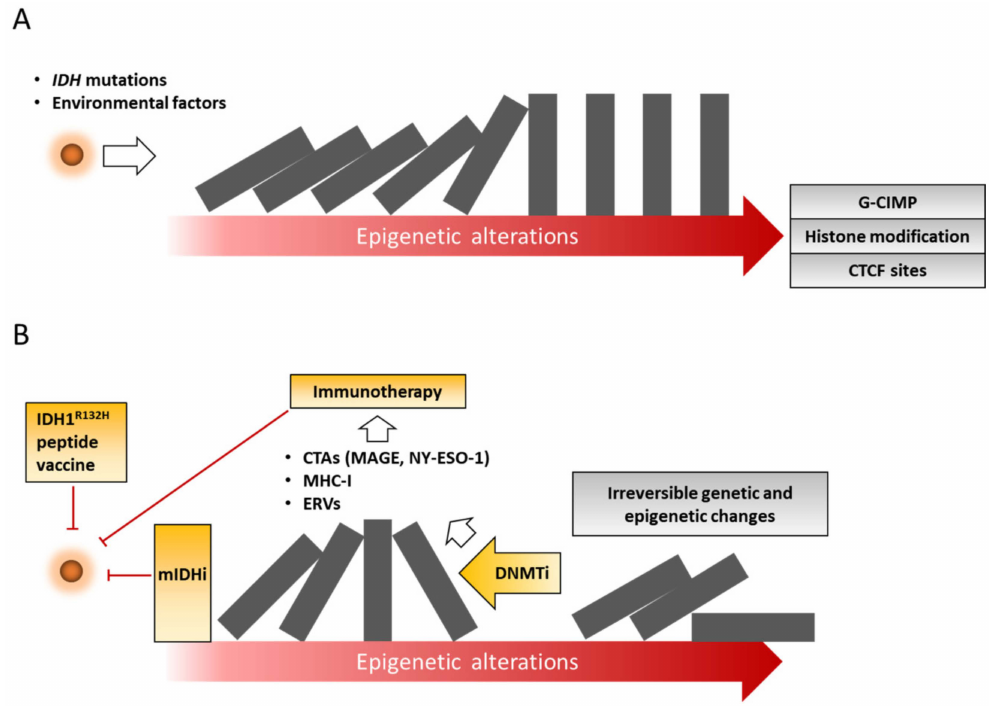
Figure 2. Schematic overview illustrating current approaches to epigenetic therapy for IDH -mutant gliomas. ( A ) IDH mutations result in epigenetic abnormalities such as DNA methylation, histone modification, and aberrant chromatin states. ( B ) Consequently, mutant IDH-driven epigenetic alterations lead to irreversible genetic and epigenetic changes. Epigenetic drugs and immunotherapy are highlighted in yellow. CTAs, cancer testis antigens; DNMTi, DNA methyltransferases inhibitor; ERVs, endogenous retroviruses; CTCF, CCCTC-binding factor; G-CIMP, glioma-CpG island methylator phenotype; MHC-I, major histocompatibility class-I; mIDHi, mutant IDH